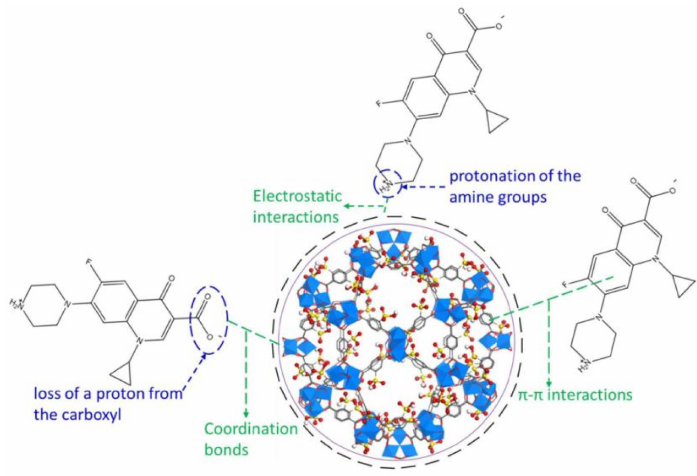
Figure 12. Possible adsorption mechanism of CIP on MIL101(Cr)-HSO 3 [125]. Reprinted by permis- sion from ref. [125]. Copyright © 2022, with permission from Springer Nature.